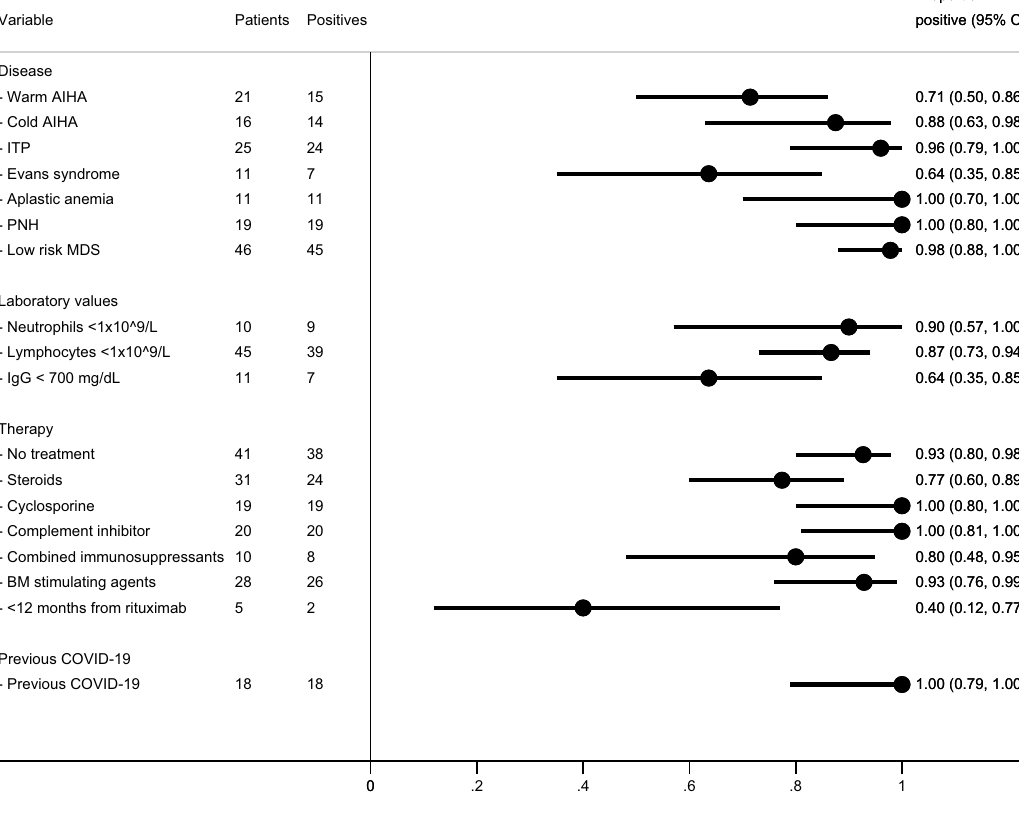
Figure 1. Predictors of seroconversion for anti-Spike IgG in patients with autoimmune cytopenias and bone marrow failure syndromes. AIHA autoimmune hemolytic anemia; MDS myelodysplastic syndromes; ITP immune thrombocytopenia; BM bone